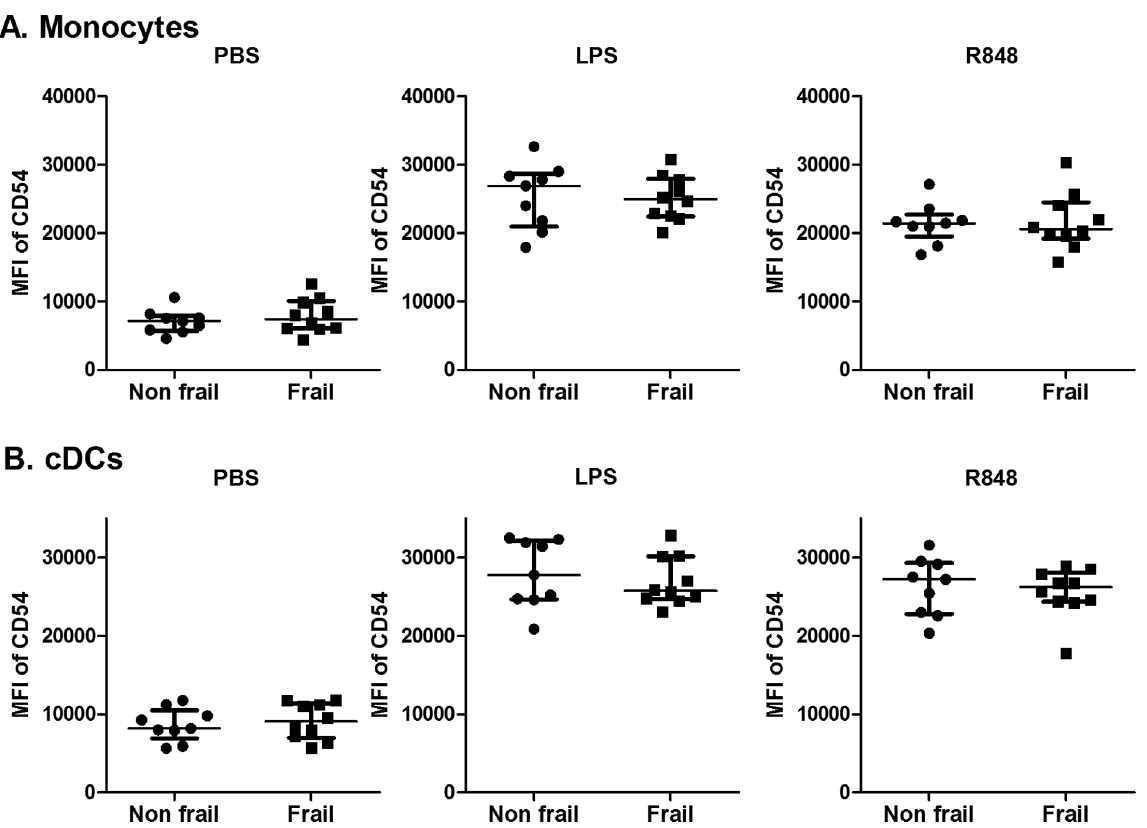
Figure 4. Activation state (CD54) of cDCs and monocytes in non frail and frail old subjects. Whole blood cells were stimulated or not with LPS or R848 during 5 h. Expression of CD54 was assessed for (A) monocytes (Lineage – HLA-DR + CD11c + CD14 + ), (B) cDCs (Lineage 2 HLA- DR + CD11c + CD14 2 CD123 2 ). MFI (mean) values for each donor are shown. The bars represent median values 6 interquartile range.